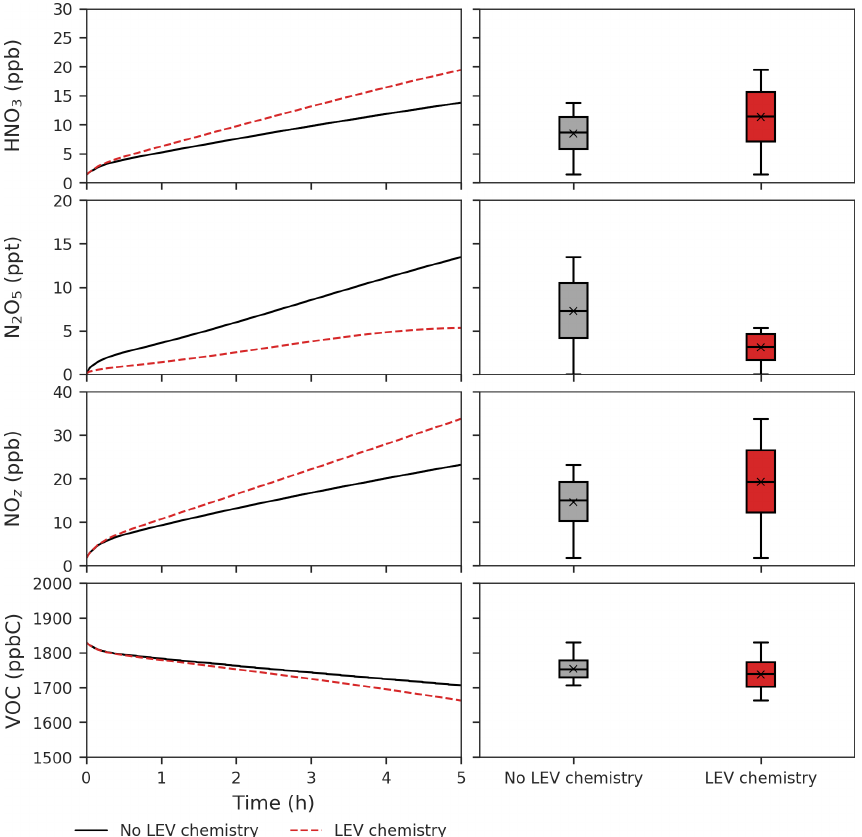
Figure 6. Effects of LEV chemistry on HNO 3 , N 2 O 5 , NO z and VOCs (in red, relative to the case without LEV chemistry shown in black or gray). The time series represent averages of simulations performed with LEV chemistry (dashed red line) and without LEV chemistry (black line) over the 5h timescale. The box plots show the distributions of the species concentration for the entire 5h. Note that findings shown here are determined over a range of F values depending on experimental